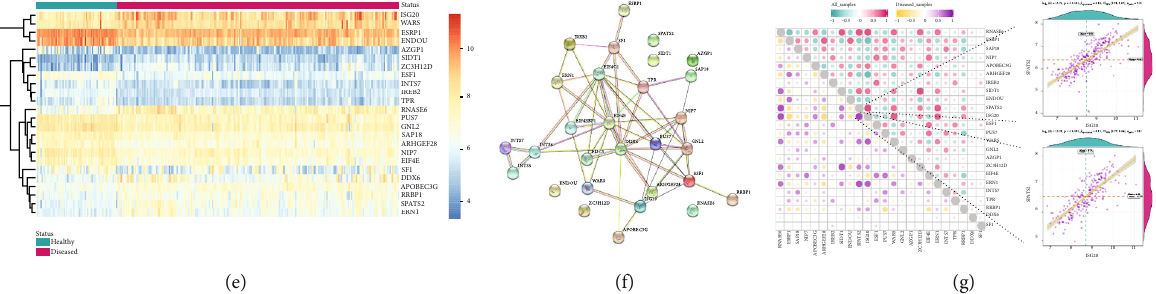
Figure 1: Expression landscape of RNA binding proteins (RBPs) in periodontitis. (a) The overview of RBPs ’ regulatory role in periodontitis. (b) A summary of the types of RNA which the RBPs were binding to. (c) The volcano plot demonstrated the di ff erentially expressed RBPs in periodontitis and periodontally healthy samples. RBPs with adjust p value < 0.01 and ∣ logFC ∣ >0 : 5 were considered to be signi fi cantly dysregulated, and their gene names were marked. The box plot (d) and heatmap (e) demonstrated the expression status of the 24 dysregulated RBPs between periodontally healthy and periodontitis samples. (f) The protein-protein interaction network of the 24 dysregulated RBPs. (g) The correlation among the 24 signi fi cantly dysregulated RBPs in periodontitis samples and whole samples. The most correlated RBPs in all samples and periodontitis samples were demonstrated in the dot